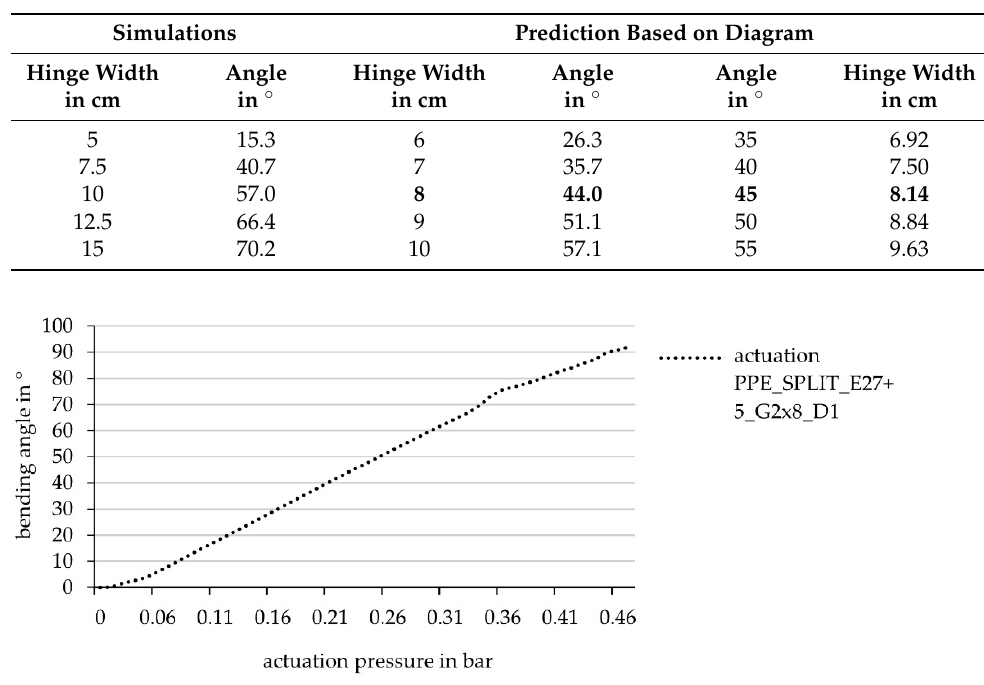
Table 3. Bending angle dependent of hinge widths (simulation) and prediction of bending an- gle/hinge width (regression formula from Figure 13 used).